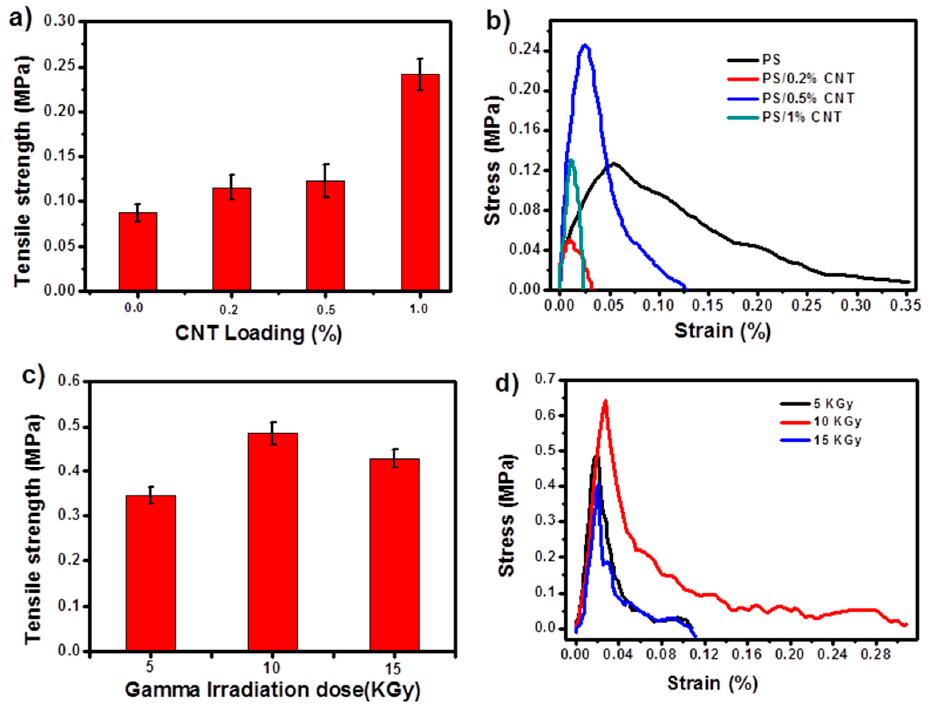
Figure 5. ( a ) Tensile strength and ( b ) stress-strain curve of pure PS and PS/CNT nanofibers; ( c ) tensile strength and ( d ) stress-strain curves of PS/0.5% CNT with different irradiation doses. The mechanical properties for PS/0.5 wt.% CNT depend on the gamma irradiation dosages. The